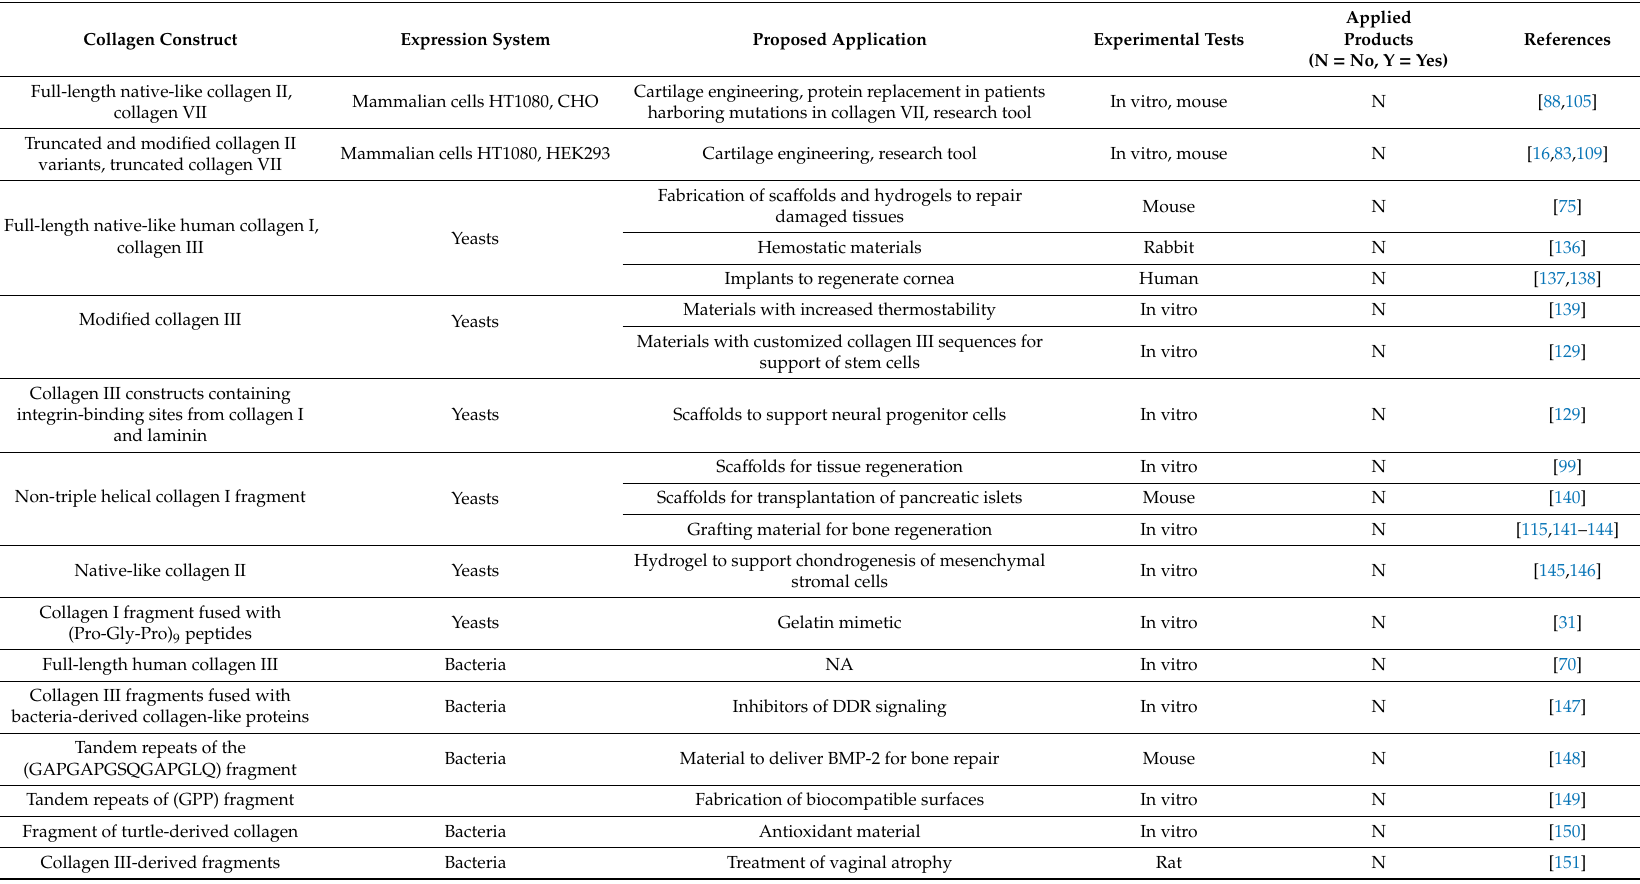
Table 2. Examples of recombinant collagen-based constructs and their potential applications in tissue repair and